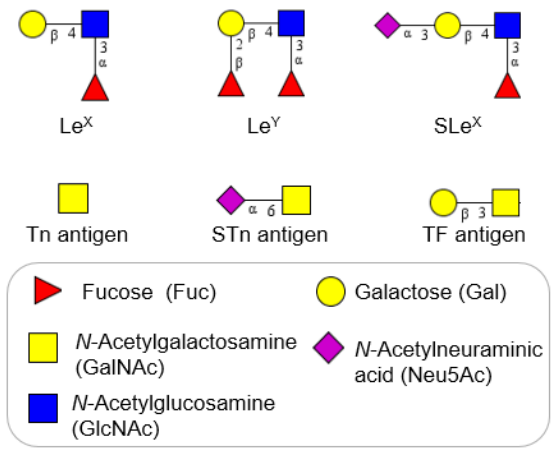
Figure 2: The major tumour-associated glycan structures observed in various types of cancer (Lewis antigens and O -glycans). Carbohydrate structures were created in